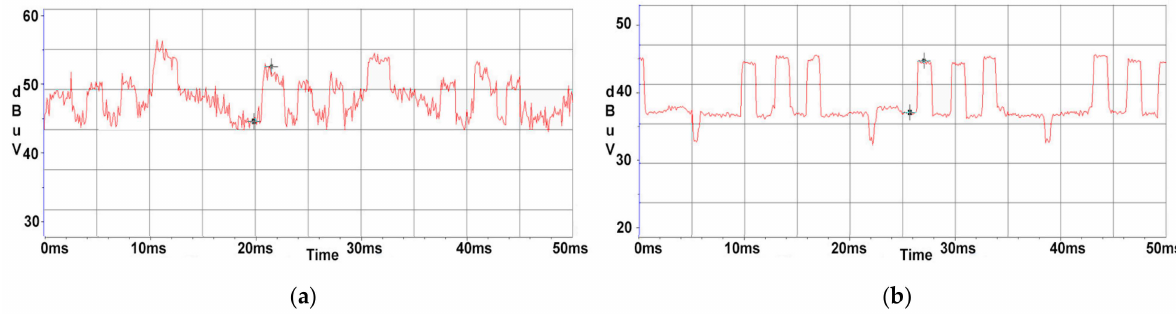
Figure 8. HP display: ( a ) displayed waveform using a Max Peak detector; ( b ) displayed waveform using an Average